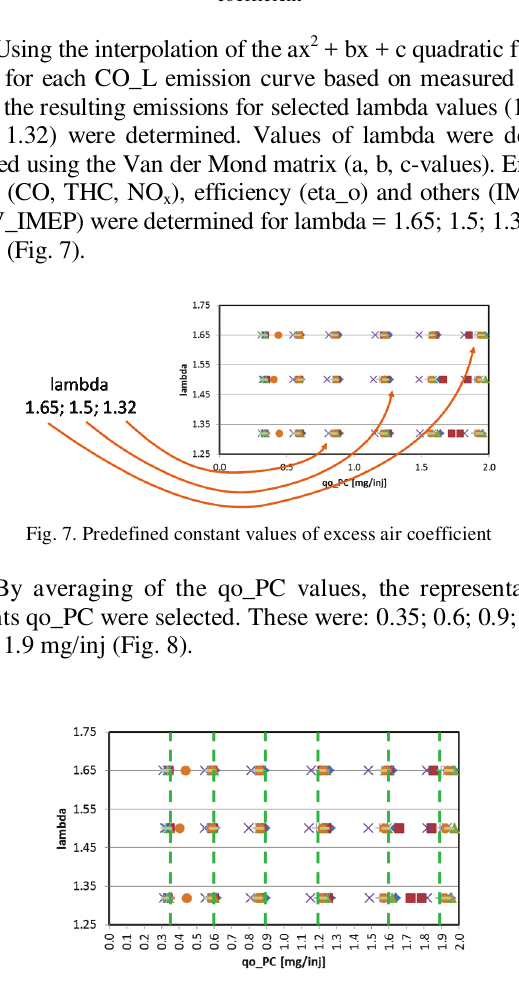
Fig. 6. The method of determining constant values of the excess air coefficient